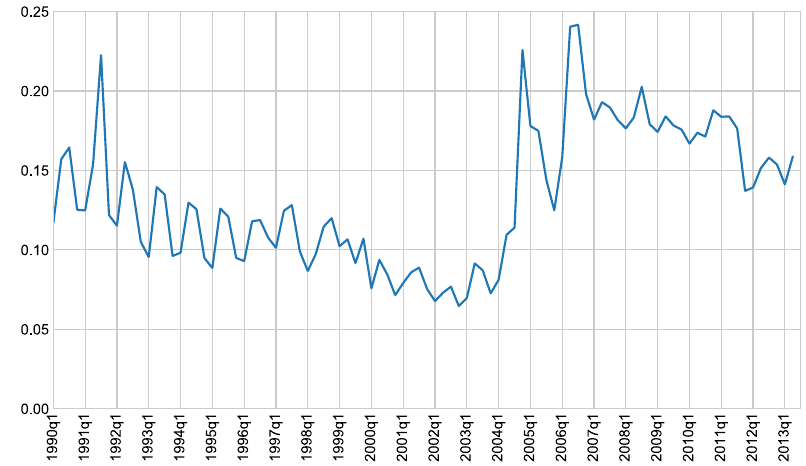
Fig. 19 Attrition of unemployment stocks in the LFS. Source :